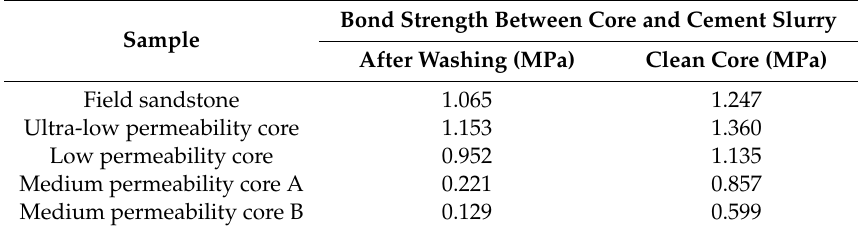
Table 5. Cementing strength of lower interface of oil-based drilling fluid.